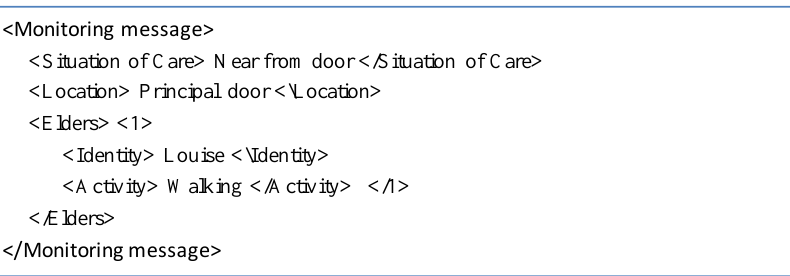
Figure 6. Format of a monitoring